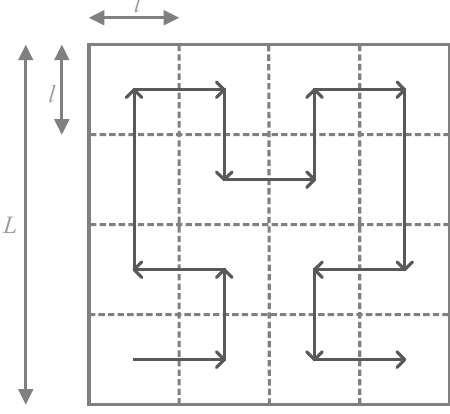
Figure 3. The length of the network and subarea.